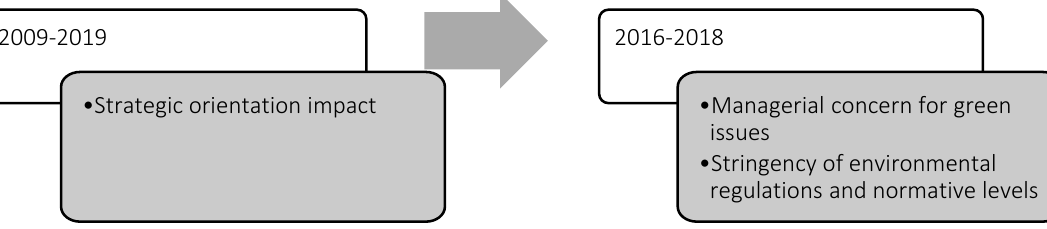
Figure 2. Trends in the development of sustainability-oriented innovation research